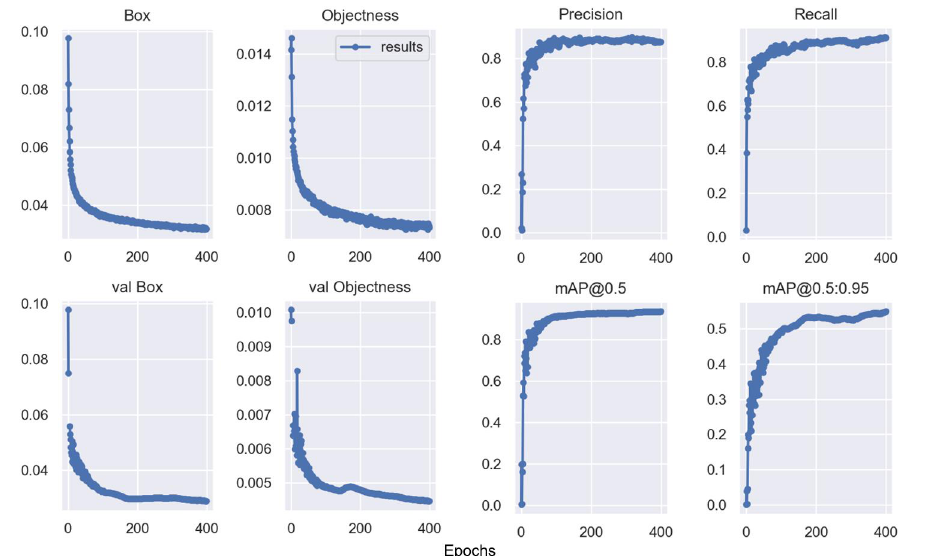
Figure 16. The relationship between loss, precision, recall, mAP, and epoch.